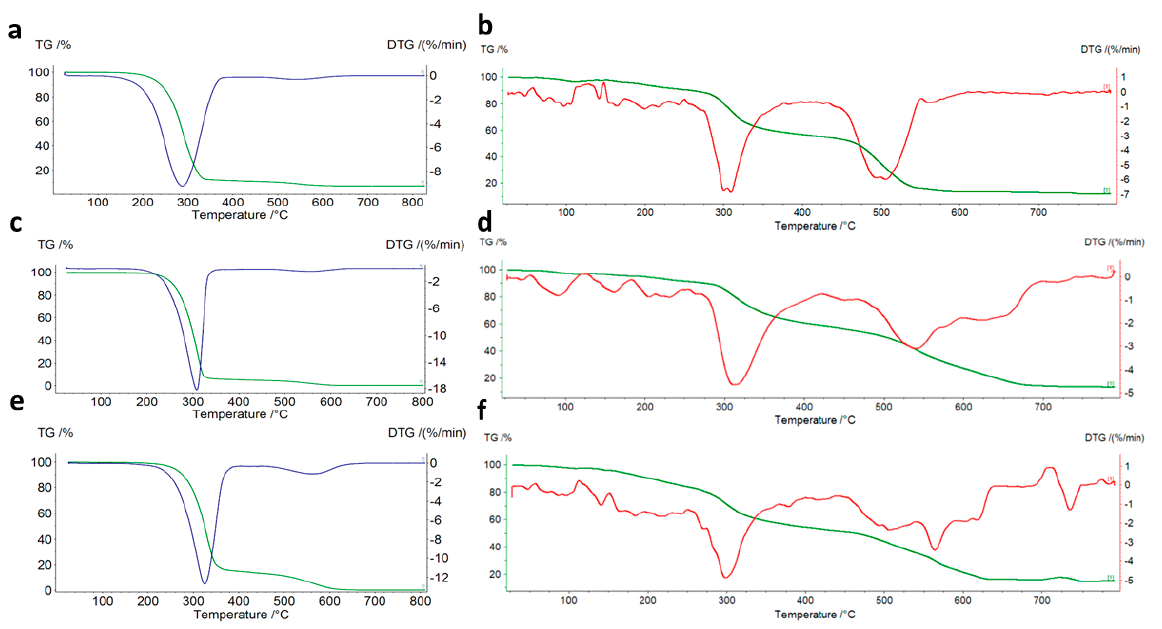
Figure 4. TG-DTG traces of the pure organic ligands and complexes: ( a ) L1; ( b ) Cu(L1) 2 Cl 2 ; ( c ) L2;